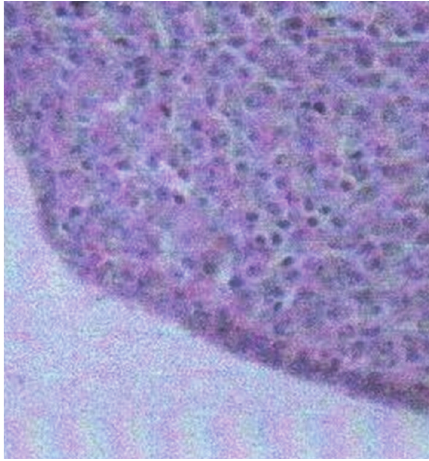
Figure 2: HPE of breast excisional biopsy showing sheets of large nucleolated and plasmacytoid cells permeating breast parenchyma.